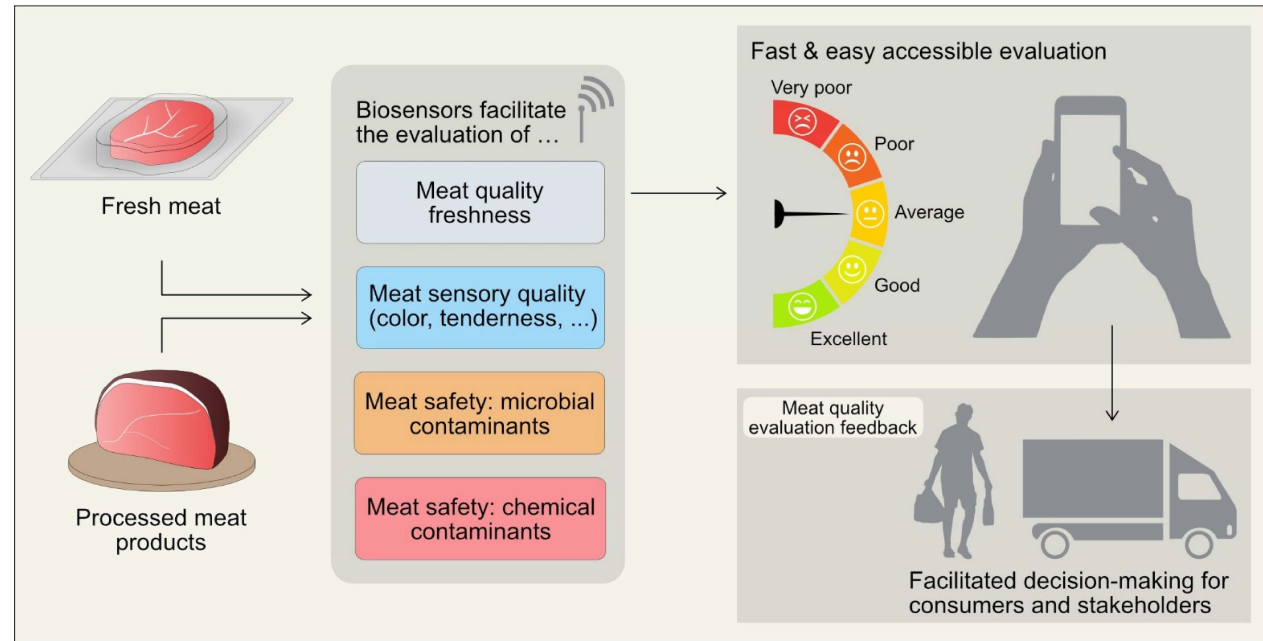
Figure 1. Schematic diagram depicting the use of biosensors to evaluate the quality of meat and meat products with the objective of facilitating decision-making for both consumers and